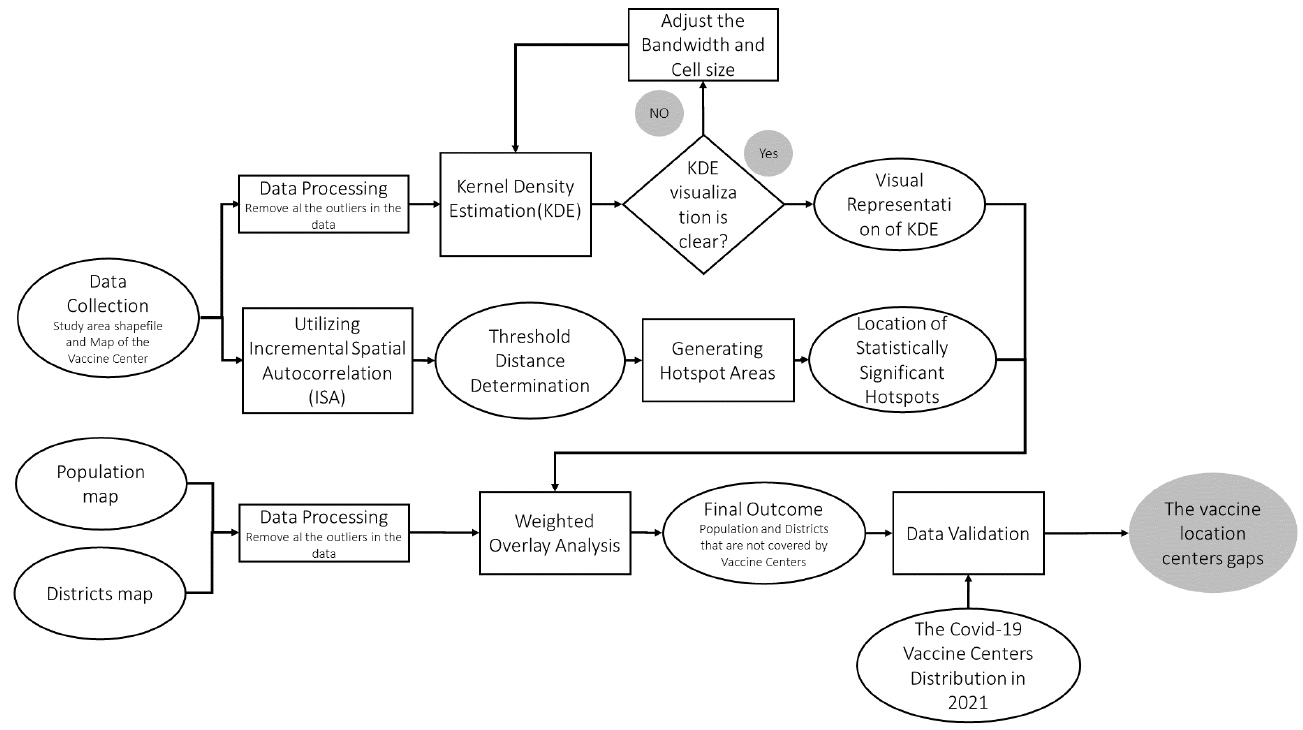
Figure 3. The workflow of the applied